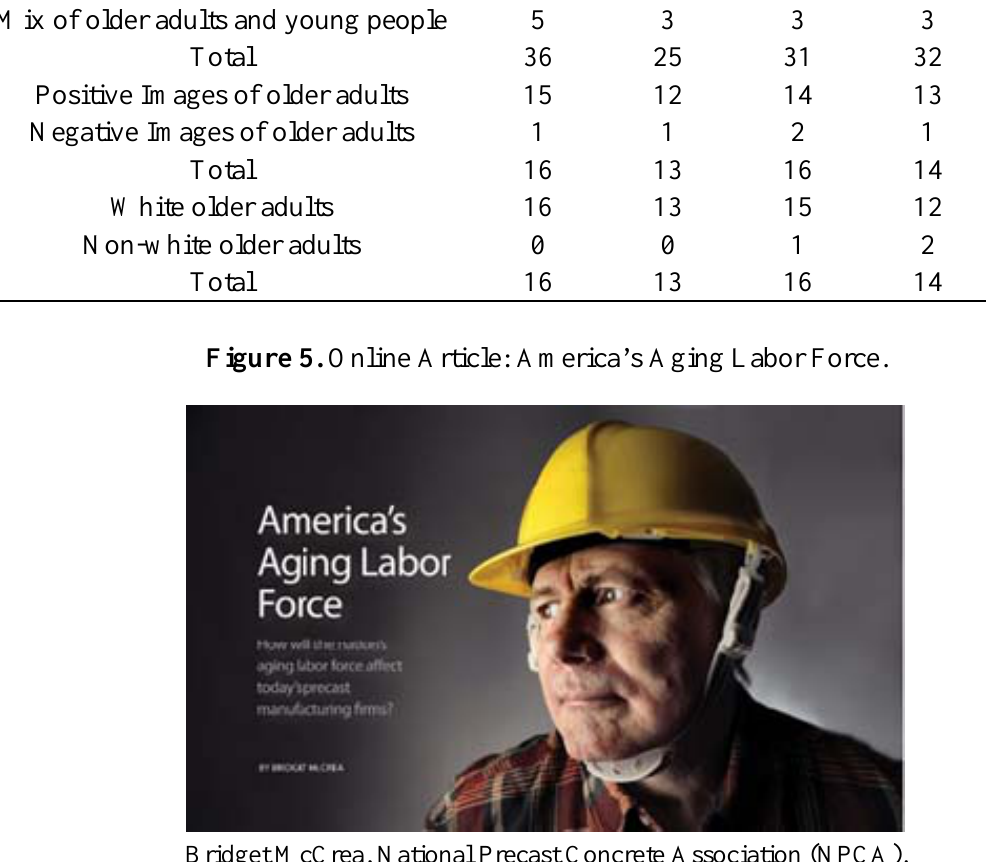
Bridget McCrea, National Precast Concrete Association (NPCA). Figure 6. CARP Health Wizard Advertisement.